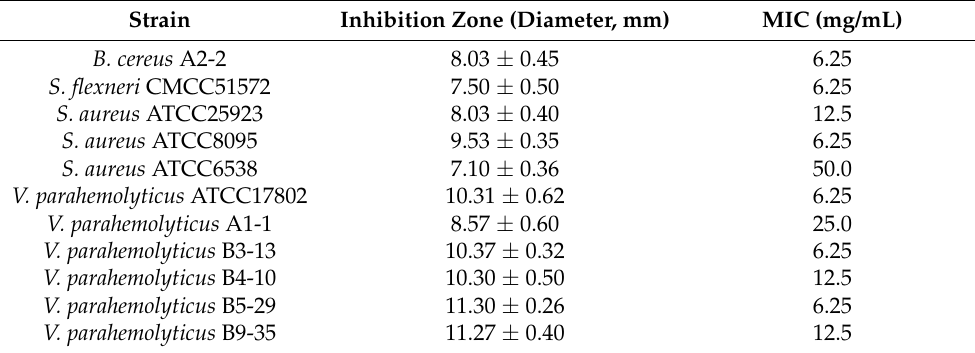
Table 2. Antibacterial activity of Fragment 1 of the methanol-phase extract from P. kleiniana Wight et